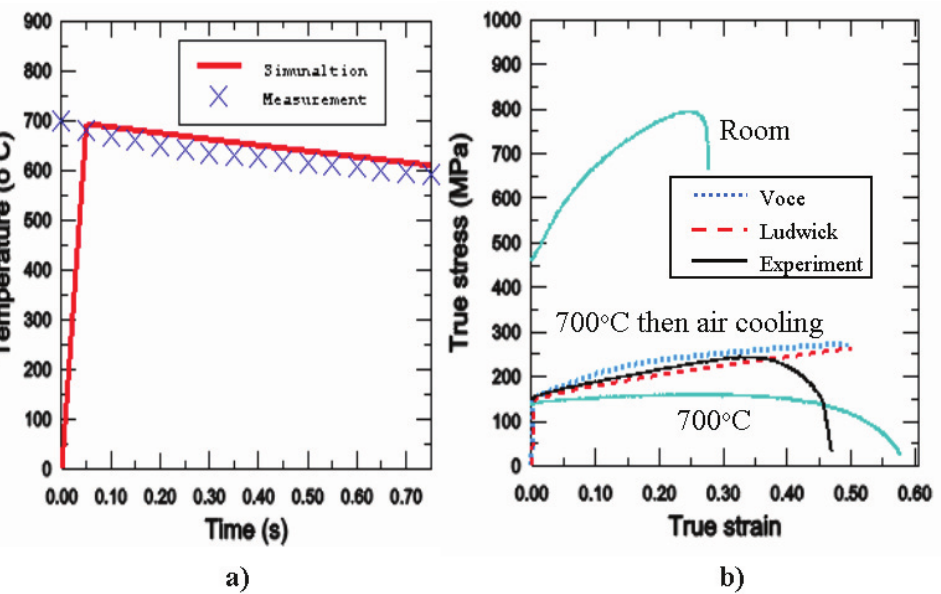
Figure 11. Comparisons of simulation and experimental results of (a) air cooling curve and (b) stress-strain curve in air cooling from 700 ı